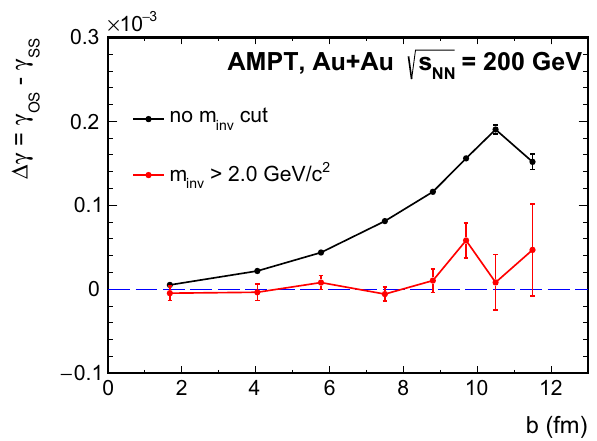
Fig. 2 The (cid:2)γ asafunctionofimpactparameter b in200GeVAu+Au collisions by AMPT for all pion pairs (black markers) and for pairs with m inv > 2 GeV / c 2 (red